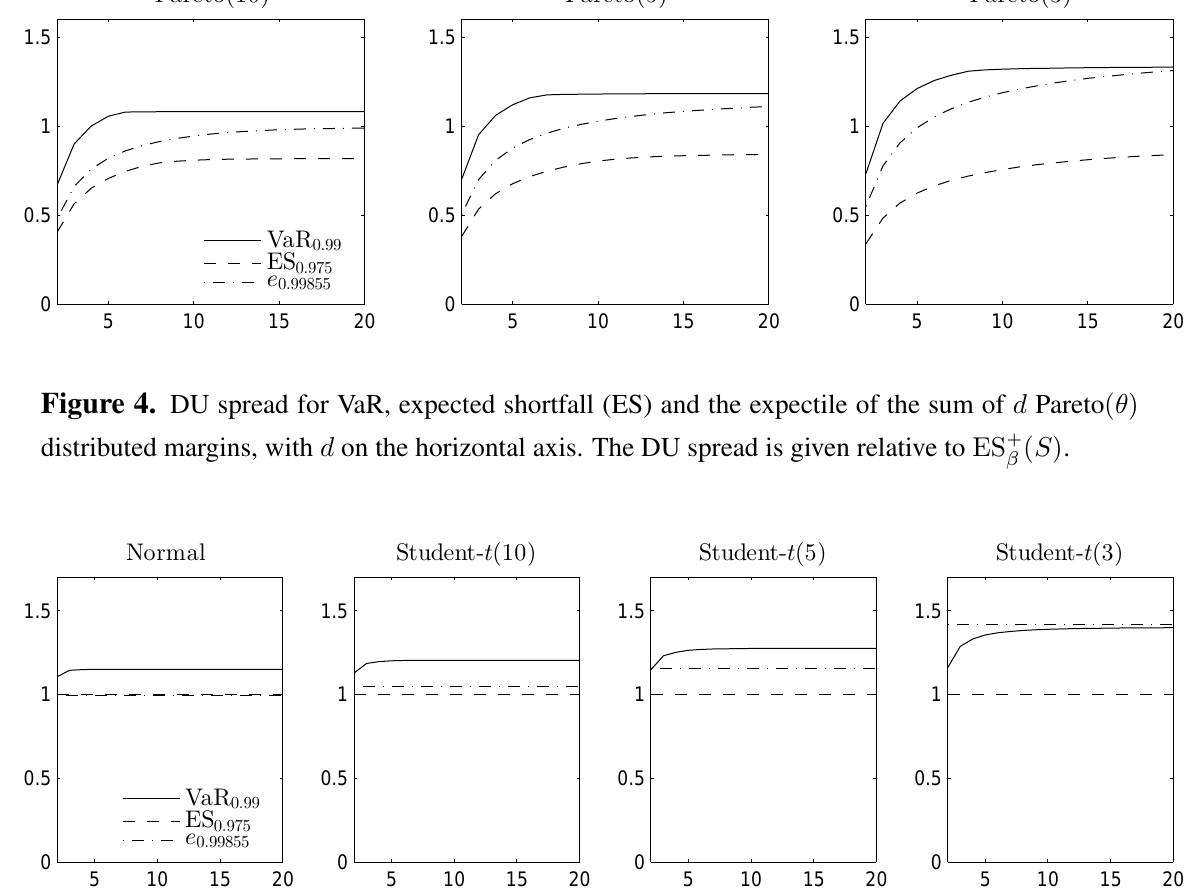
Figure 5. The DU spread for VaR, ES and the expectile of the sum of d Gaussian or Student t p ν q distributed margins, with d on the horizontal axis. The DU spread is given relative to ES `